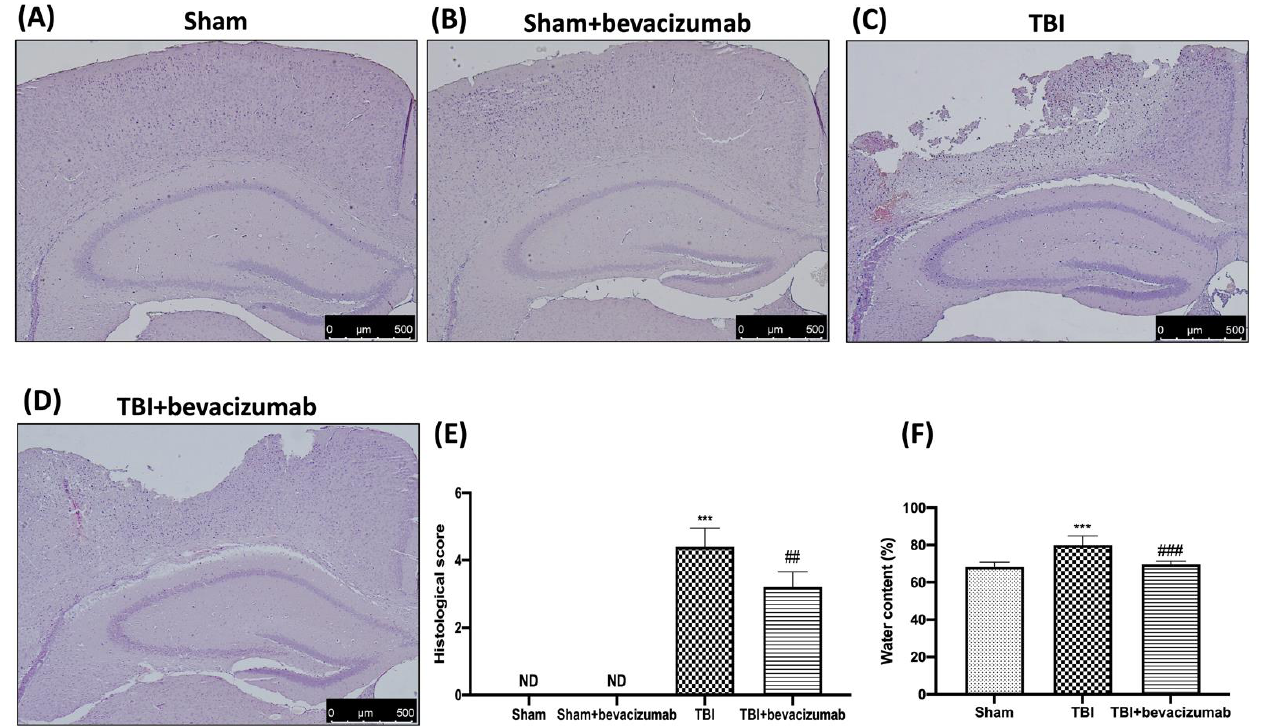
Figure 2. Bevacizumab reduces both edema and histological score. A histological investigation of brain sections showed a intact tissue structure in Sham ( A ) and Sham + bevacizumab ( B ) mice respect tissue disorganization and cell infiltration present in the TBI group ( C ). Significant protection from the TBI was apparent in bevacizumab-treated mice ( D ). The histological score was measured ( E ). Brain edema was measured by brain water content in the ipsilateral hemisphere. At 24 h after, TBI showed an increase in levels of water content in the TBI brain ( F ), while the treatment with bevacizumab decreased the water content in the TBI brain ( F ). Images are figurative of at least 3 independent experiments. Values = means ± SD of 5 animals per group; *** p < 0.001 vs. Sham; ## p < 0.01 vs. TBI; ### p < 0.001 vs. TBI